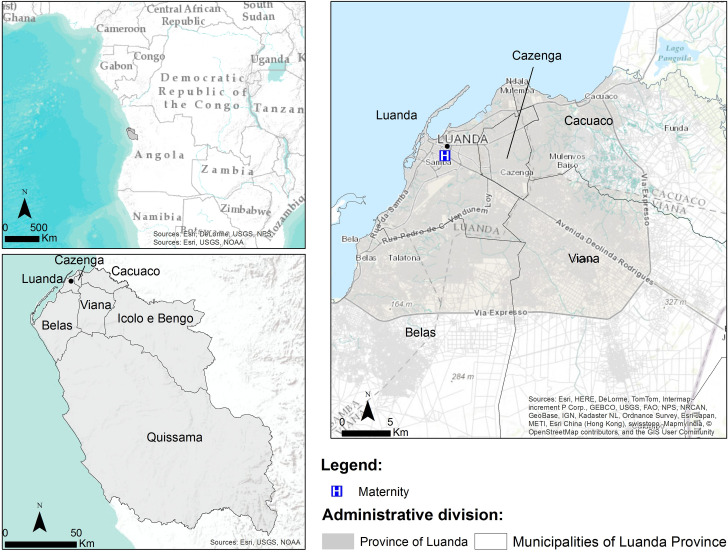
Localization of the province of Luanda, Angola, and their municipalities: Luanda, Cazenga, Cacuaco, Cazenga, Ícolo and Bengo, Luanda, Quissama and Viana.